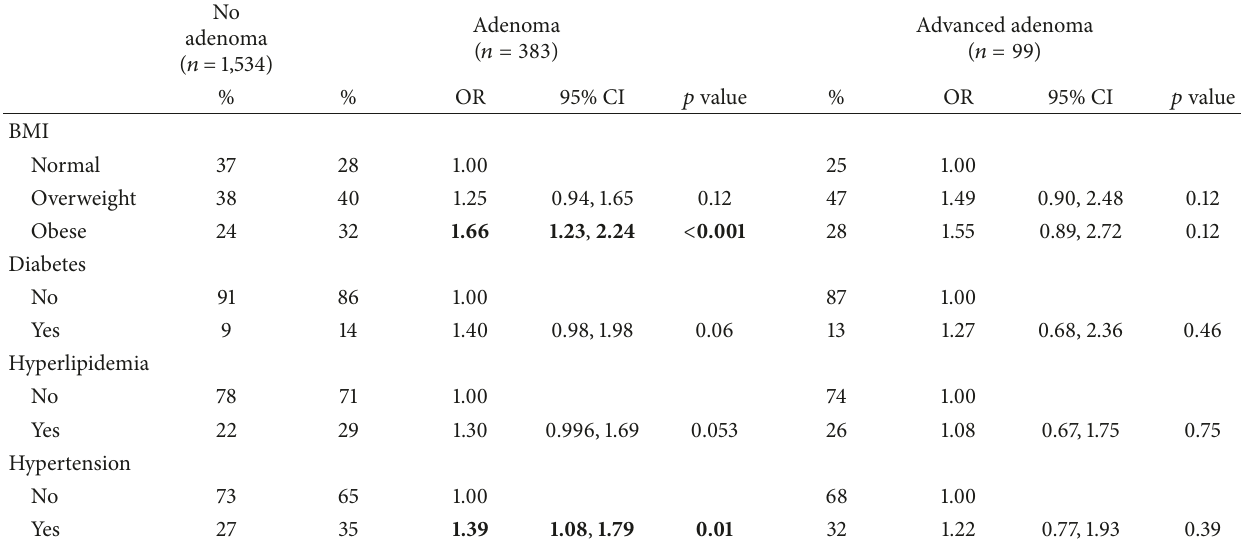
Table 4: Risk of neoplasia with HT, HL, DM, or increased BMI, adjusted for age, sex, and smoking status.